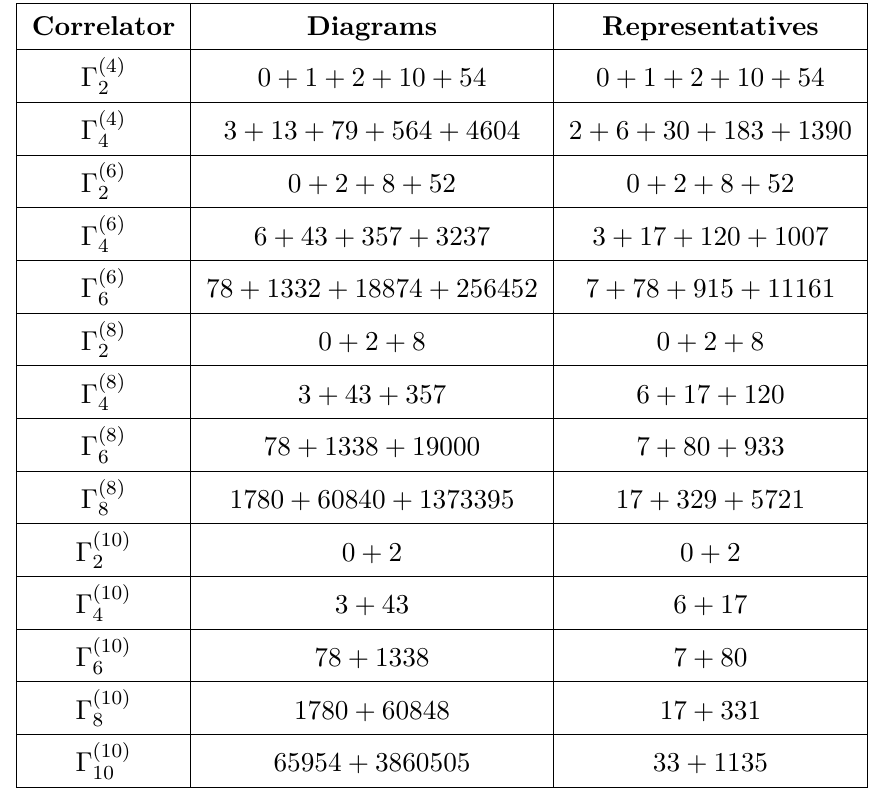
Table 2 . The same as table 1 for the complex